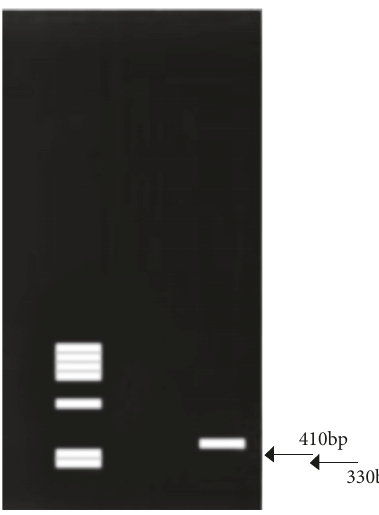
Figure 6: RT-PCR showing ESW-FLI1 fusion